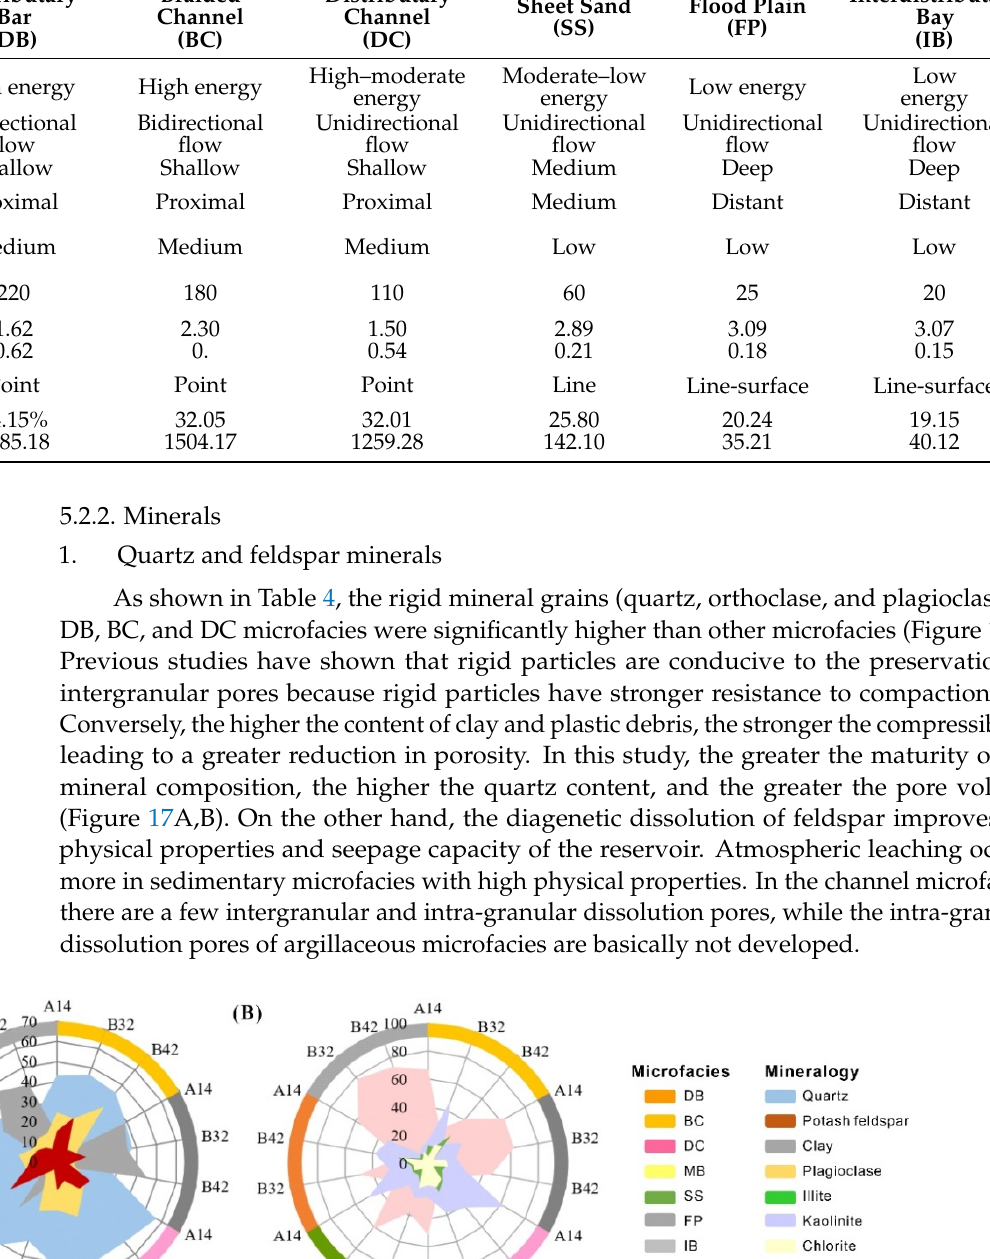
Figure 17. ( A ) Compositional maturity and plane porosity distribution. ( B ) Correlation between compositional maturity and plane porosity. 2.